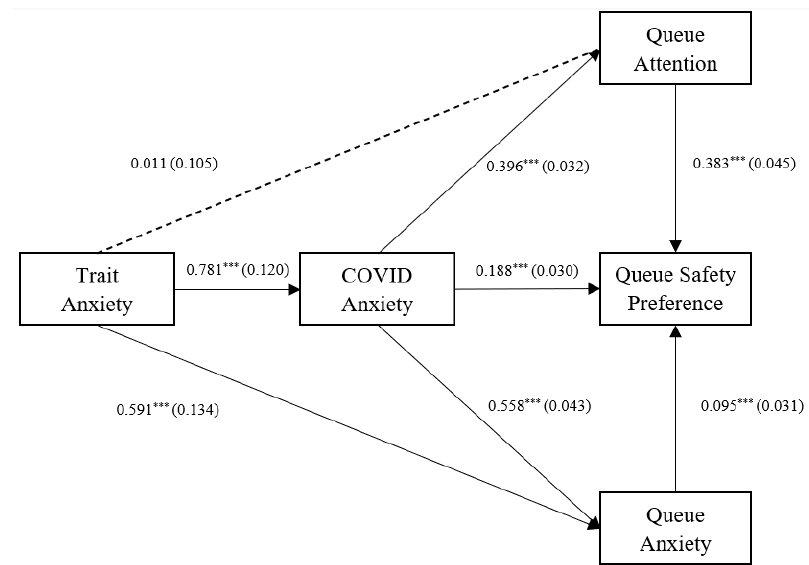
Figure 3. Final path analysis using queue attention and queue anxiety as observed variables. Unstandardised estimates are shown between variables with standard errors in parentheses. *** p < 0.001. ** p < 0.01,